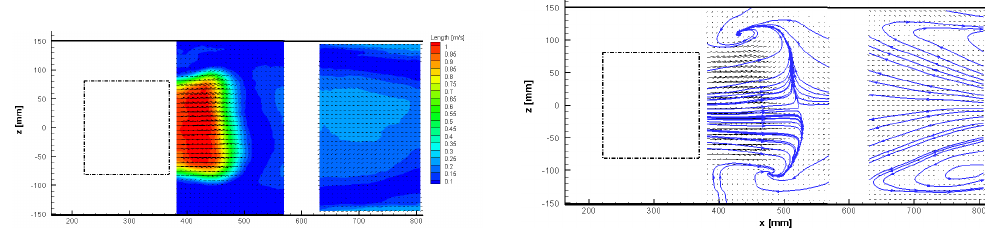
Figure 30. PIV measurements, the magnitude of time-averaged 2D velocity (left panel) and vector lines in horizontal plane ( y = 170mm )